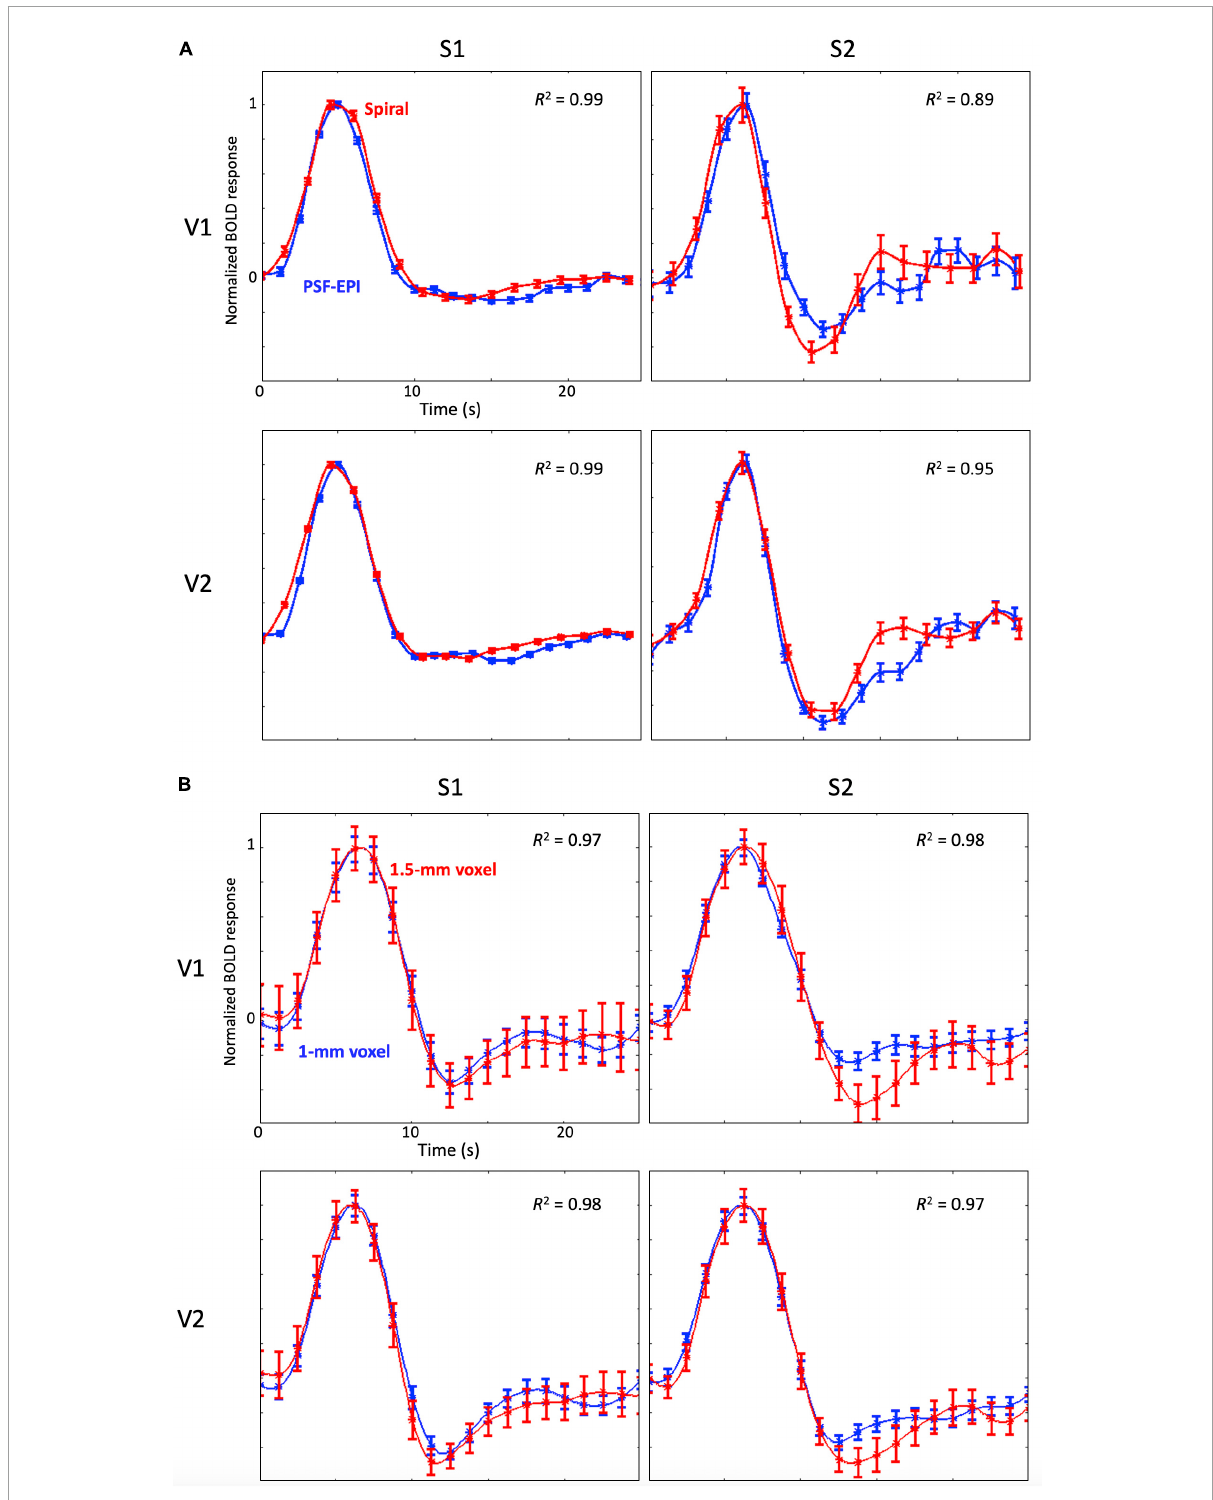
FIGURE8 (A) Examples of the mean HRFs measured with the spiral sequence (red) and the PSF-EPI (blue) for two subjects at 3T; the error bars show standard error of the mean. Note that HRFs are normalized by their peak amplitude. (B) Examples of the mean HRFs with 1.5-mm sampling (red) and 1-mm sampling (blue) for two subjects at 9.4T; error bars show standard error of the mean. Note that HRFs are normalized by their peak